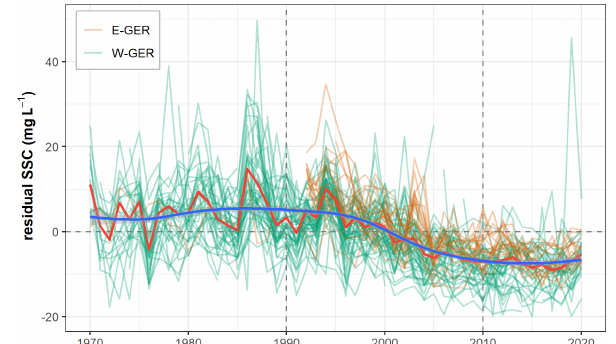
Figure 8. SSL decline ( − dSSL / d t ) as a function of discharge for all stations with a significant change in SSL between 1990 and 2010. Linear